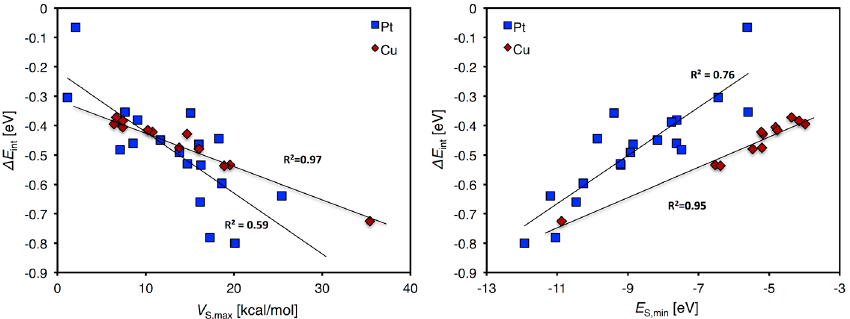
Figure 6. Shows the total correlation for Pt (blue squares) and Cu (red rhombs) atoms for the site resolved H 2 O interaction energy of the Pt 13 , Pt 7 Cu 6 and Cu 13 nanoclusters combined (e.g., are all Pt atoms of all three compounds in the Pt series) versus the local V S,max ( left ) and E S,min ( right ).